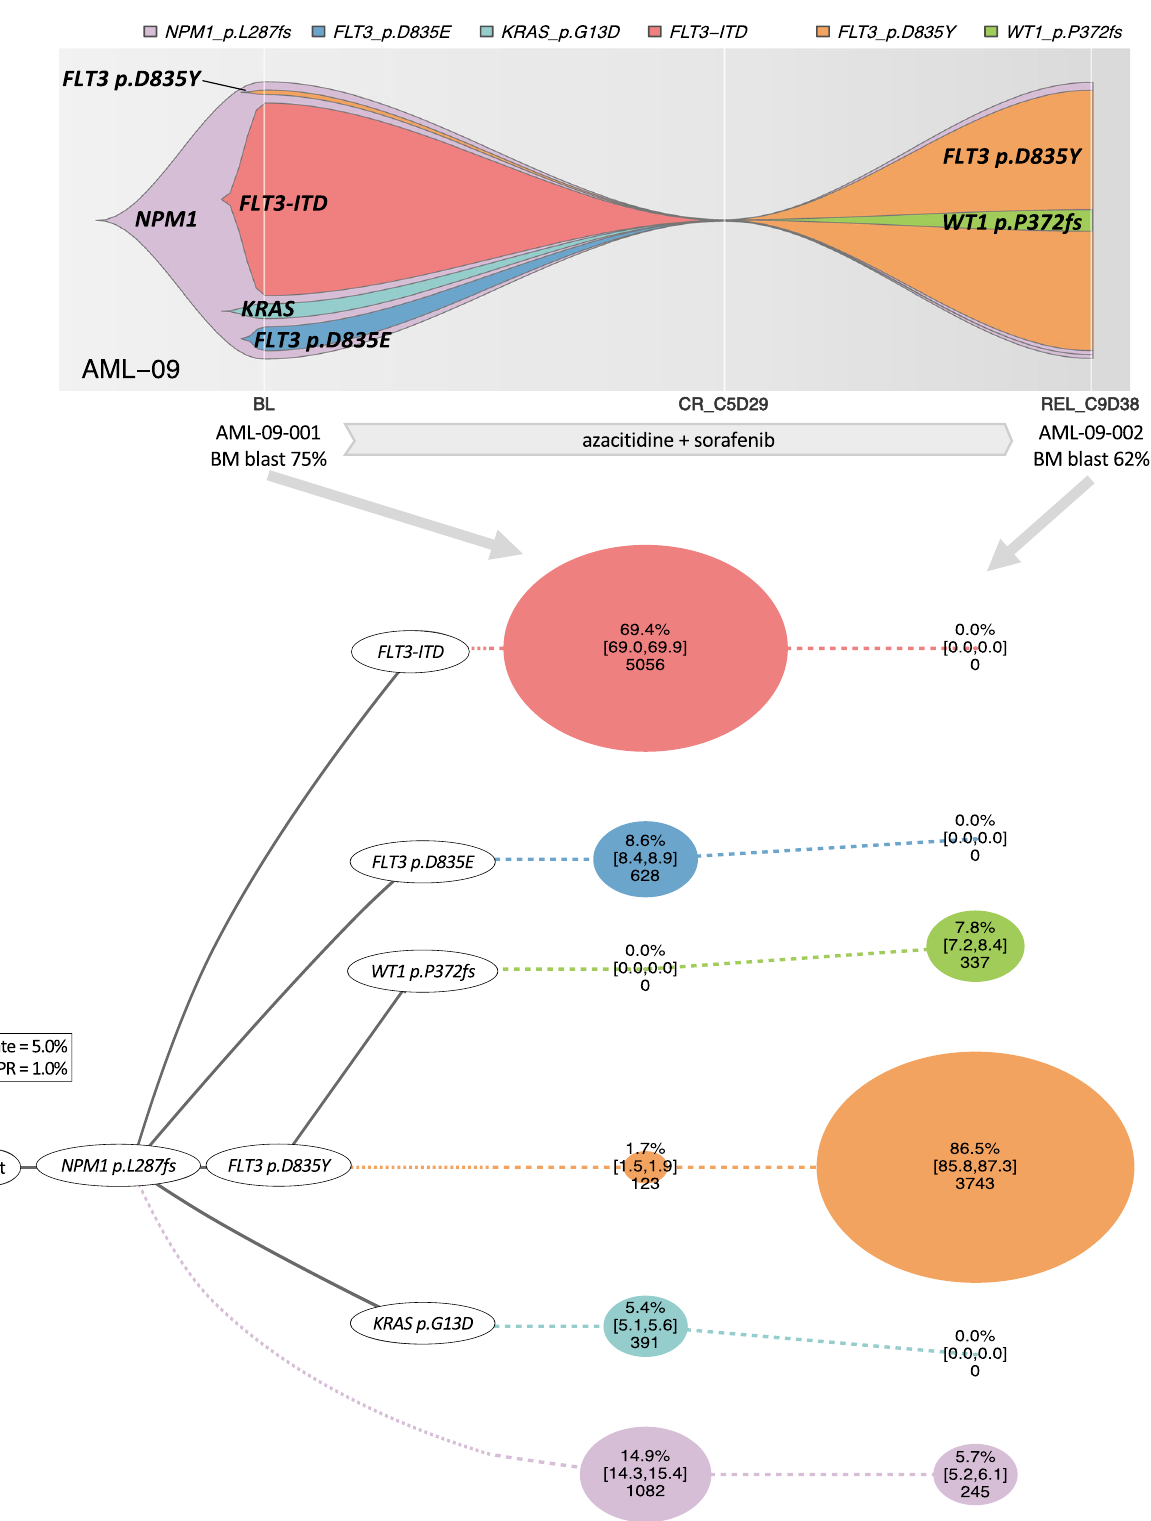
Fig. 6 Clonal selection in response to FLT3 inhibitor-containing therapy. A 74-year-old man with newly diagnosed therapy-related acute myelomonocytic leukemia showing a selection of FLT3 p.D835Y clone during a FLT3 inhibitor-containing therapy. The fi sh plot shows the inferred clonal evolution pattern based on the single-cell genotype data. The phylogenetic trees visualize the estimated order of mutation acquisition and the proportion of subclones with a different combination of mutations at each timepoint. The wild-type cells which did not carry any driver mutations are not shown. BL baseline, CR complete remission, C cycle, D day, REL relapse, ADO allele dropout, FPR false-positive rate. Full case description is available in Supplementary